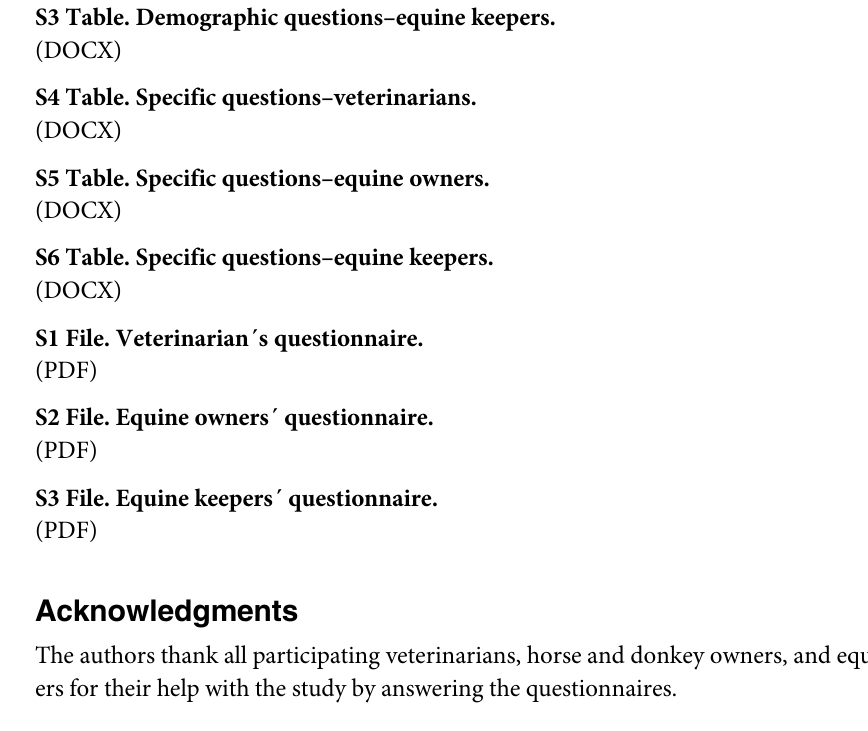
S2 Table. Demographic questions–equine owners. S3 Table. Demographic questions–equine keepers. S4 Table. Specific questions–veterinarians. S5 Table. Specific questions–equine owners. S6 Table. Specific questions–equine